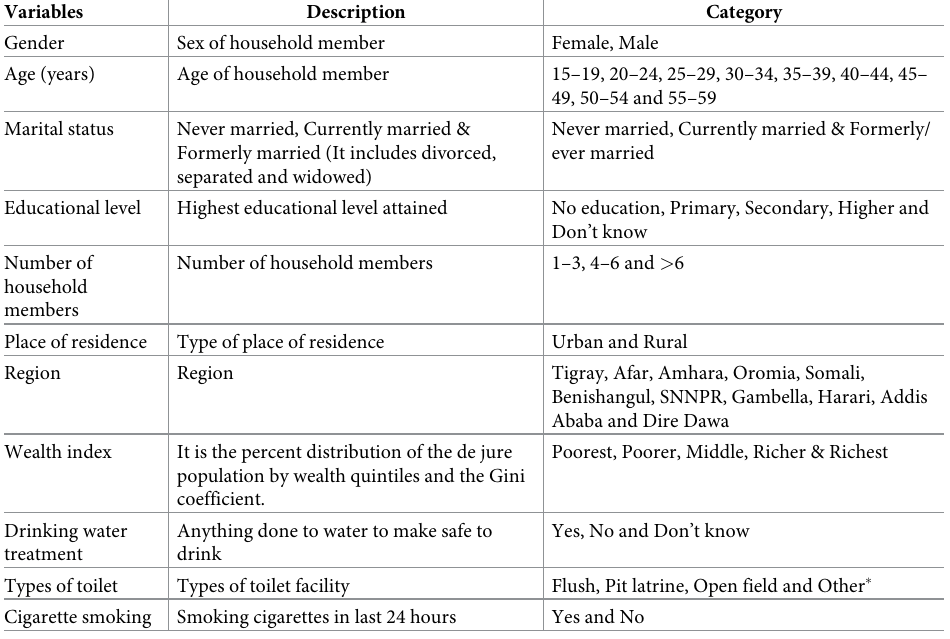
Table 1. Description of explanatory variables used in the